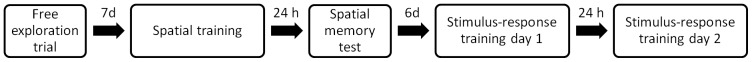
Experimental design of training and memory testing.